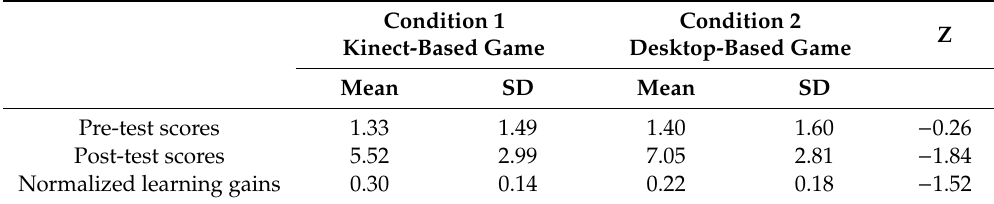
Table 3. Pre-test scores, post-test scores and normalized learning gains on content knowledge about nutrition per condition.